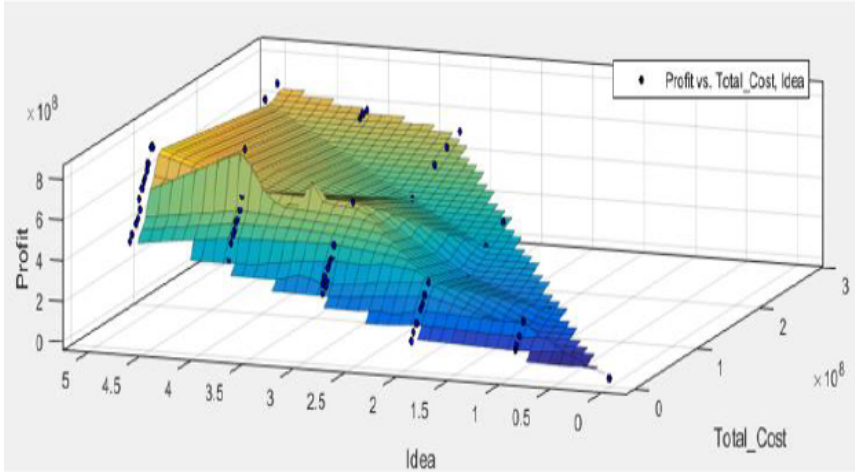
Figure 5. The curves of correlation between ideas, total cost, and profit in dynamic SMES.